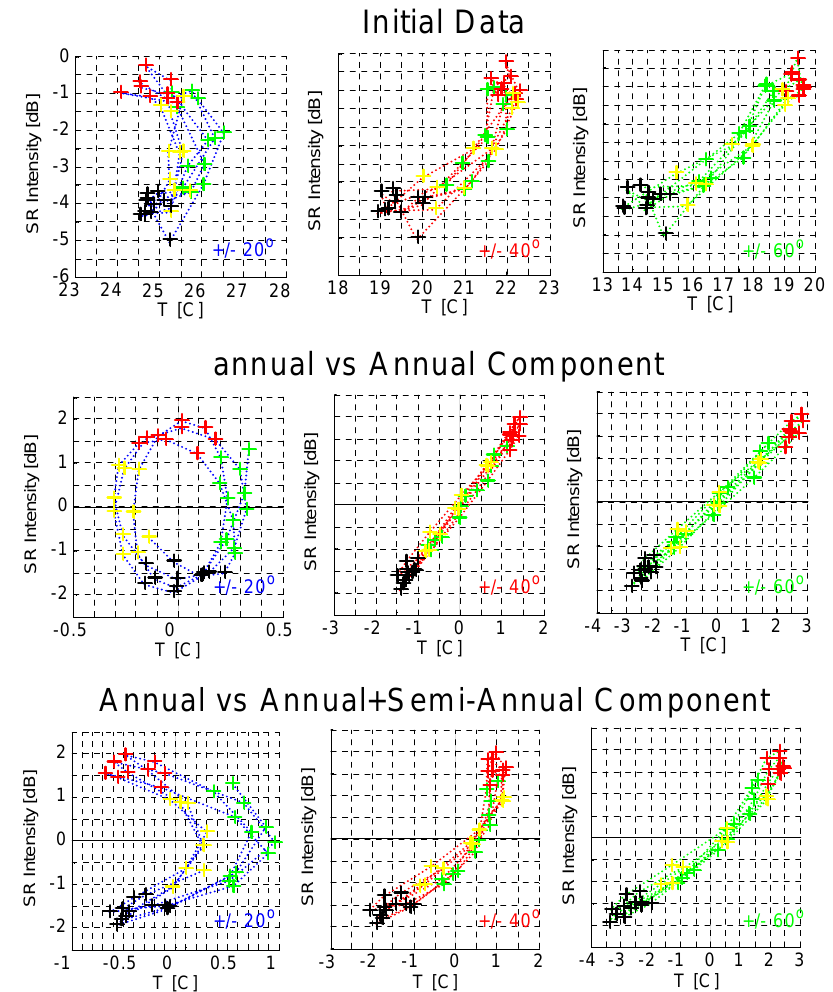
Fig. 7. Lissajous figures of global land temperature versus Schumann resonance intensity. The color of plot indicates season (green: spring, red: summer, yellow: autumn, and winter: black). ical ± 20 ◦ region. The central plots correspond to a ± 40 ◦ latitude interval, and the right column depicts the data for a ± 60 ◦ belt. Table 1 Annual and semi-annual components extracted from the data series by the PCA The left frame in the middle row shows that the annual component of temperature in ± 20 ◦ latitudes is in advance by about three months with respect to the annual variations of Schumann resonance intensity. The plot is practically a circle. Annual temperature variations in wider belts occur in phase with the electromagnetic data, and we observe the straight line in the central and right frames of the middle row. The lower plots depict the sums of the annual and semian- nual components extracted from the records. The left plot reminds us of a typical Lissajous figure for two sinusoidal signals, with the frequency ratio 2:1. The central and right plots are just the same in-phase variations of the middle row, but slightly “spoiled” by the “second